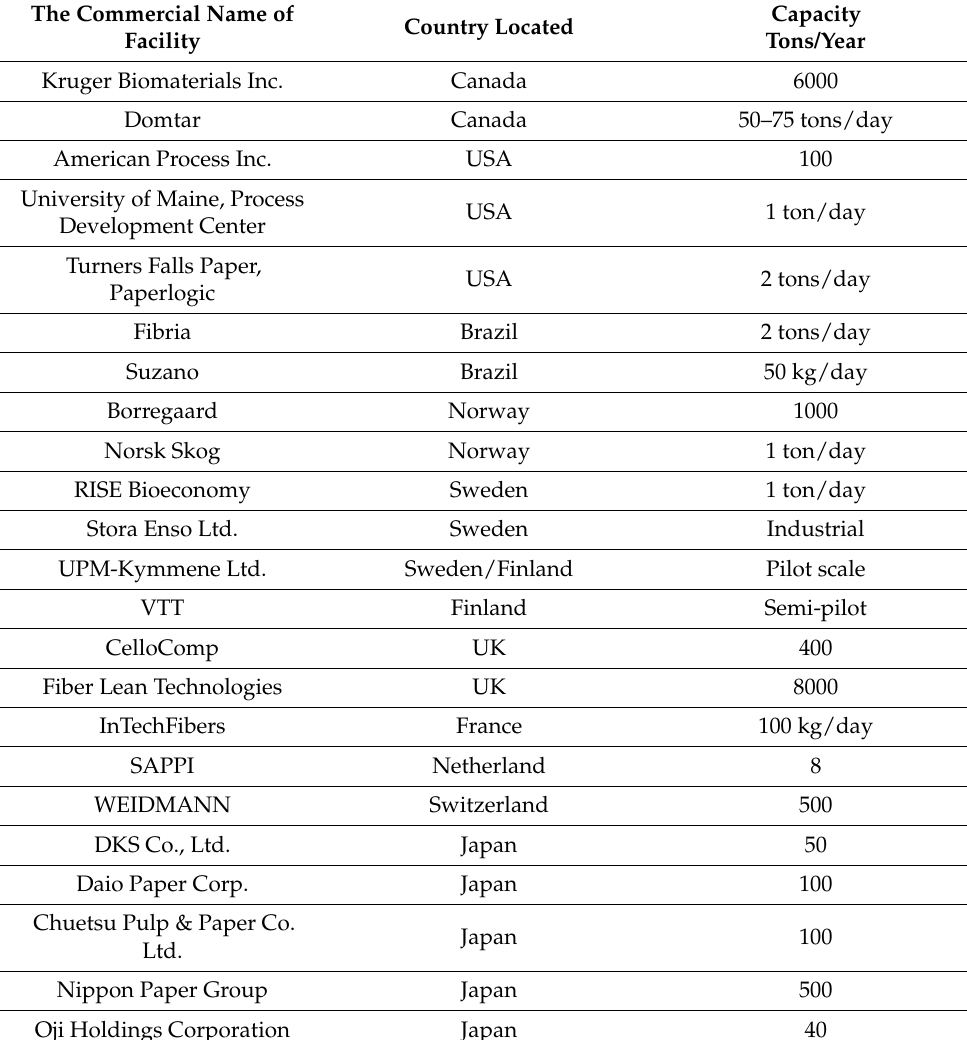
Table 7. Most recent list of implemented facilities for the commercial production of CNFs